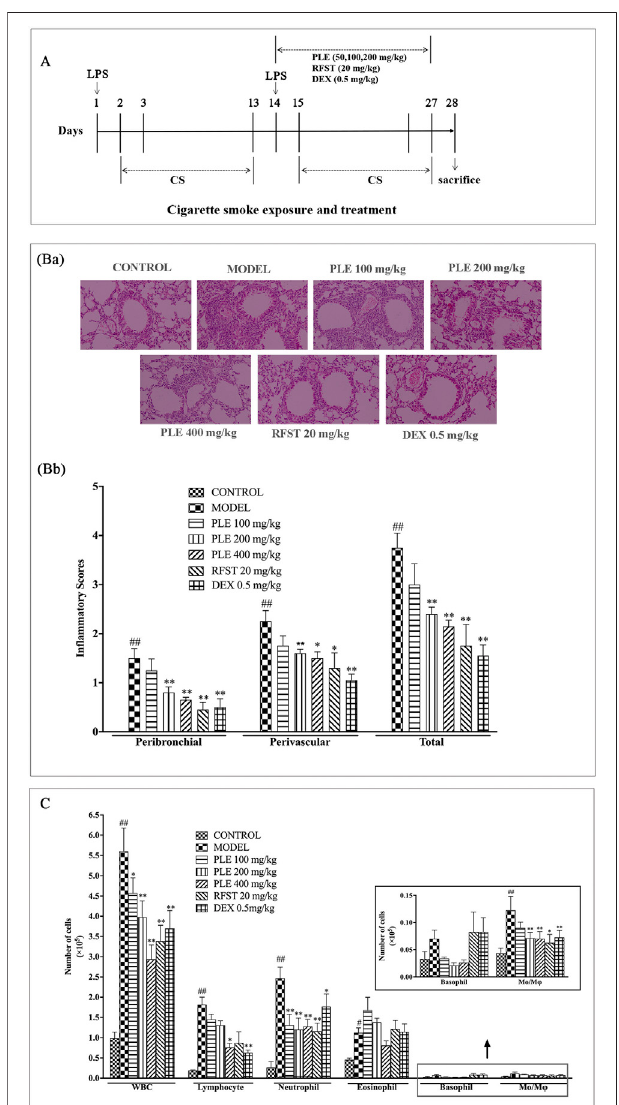
FIGURE 1 | Effects of the PLE on lung in fl ammatory cell in fi ltration in COPD mice. (A) Timeline of the experimental protocol. (Ba) Typical histological images of H&E-stained lung tissues from LPS/CS-induced COPD mice(magni fi cation × 100). (Bb) Thein fl ammatoryscoresofH&E-stained lung tissues (5 independent slices from each mice, n (cid:2) 3). (C) Total and differential leukocyte counts in the BALF (n (cid:2) 8). Data were shown as mean ± SEM; # p < 0.05 and ## p < 0.01 compared with the CONTROL group; * p < 0.05 and ** p < 0.01 compared with the MODEL